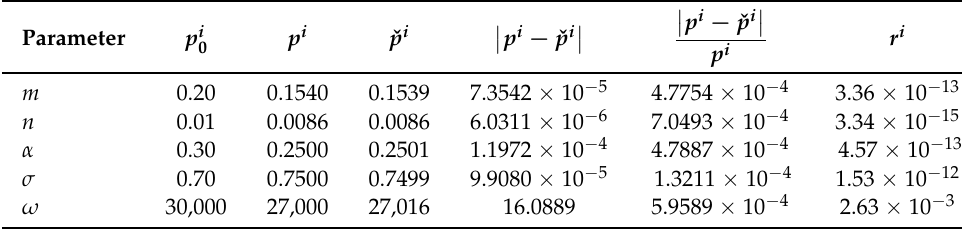
Table 3. Test with Caputo model (3a)–(3c) with different values of r and q .